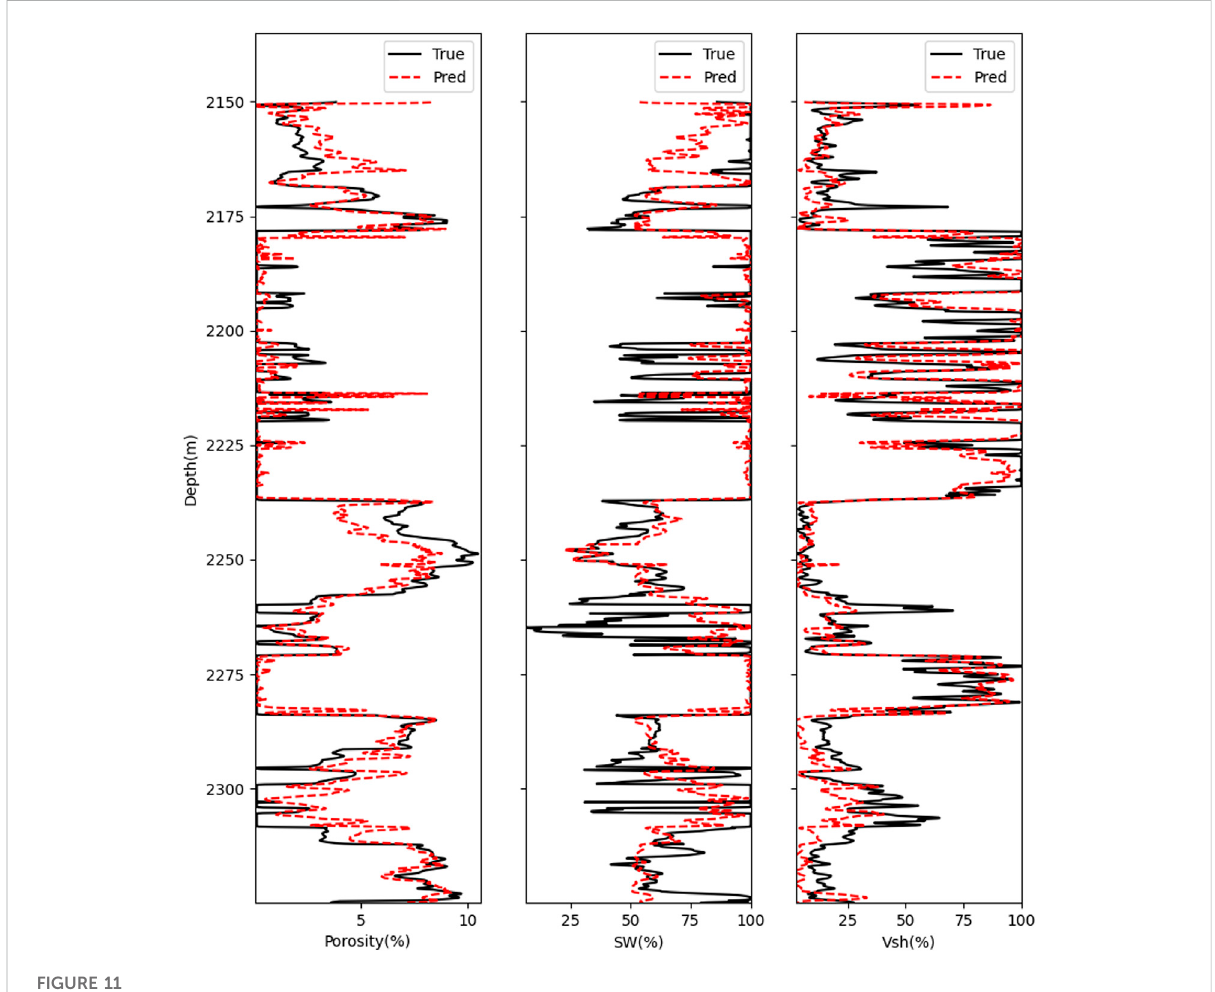
FIGURE 11 Prediction effect of GRNN on well